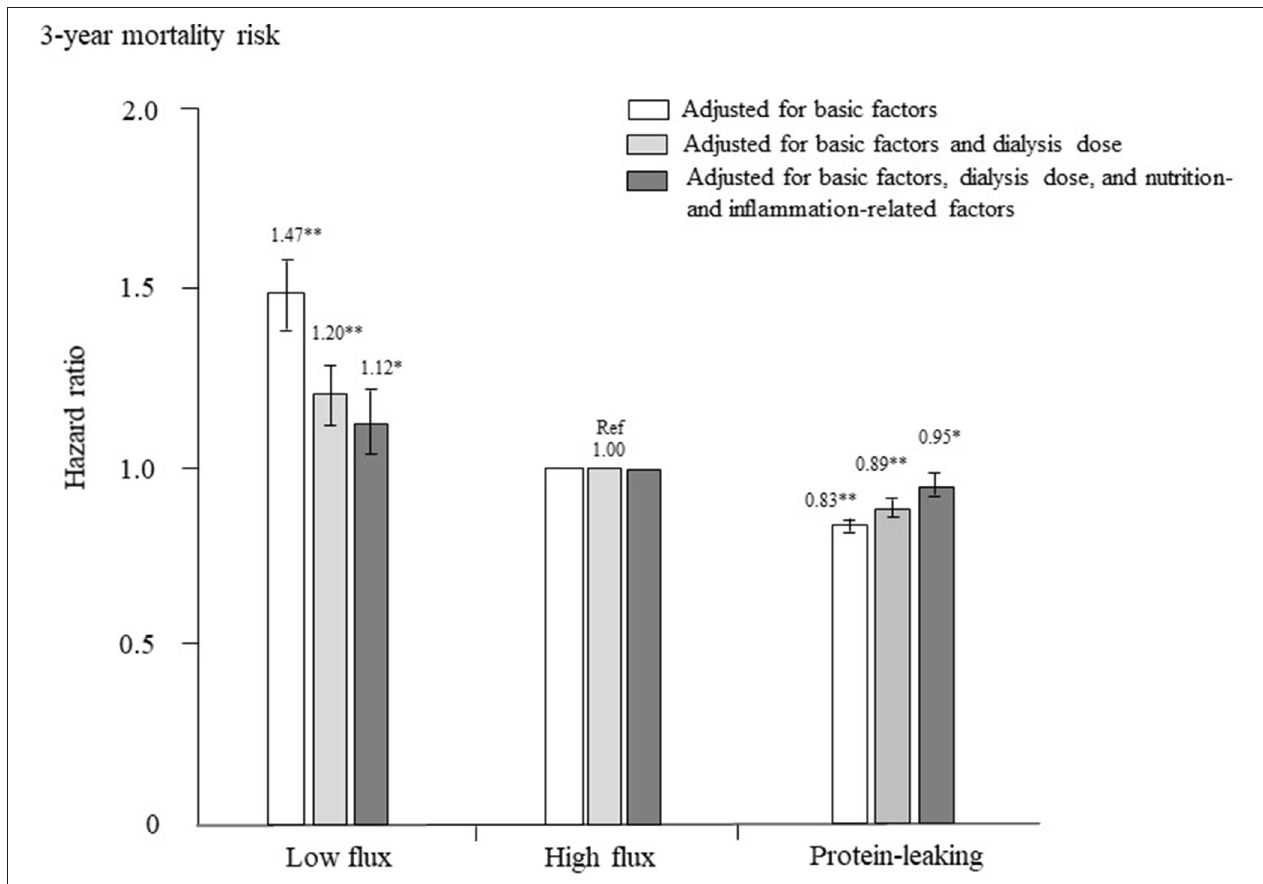
FIGURE 3 | Hazard ratios for all-cause mortality among the three dialyzer types in 238,321 patients undergoing hemodialysis, determined using standard Cox proportional hazards regression. White bars are adjusted for basic factors, including age, sex, dialysis vintage, presence/absence of diabetes mellitus, and presence/absence of cardiovascular complications. Gray bars are adjusted for dialysis dose, as assessed by Kt/V and β 2 -microglobulin levels, in addition to basic factors. Dark gray bars are adjusted for basic factors, dialysis dose, and nutrition- and inflammation-related factors, including body mass index, levels of C-reactive protein, hemoglobin, calcium, phosphate, intact parathyroid hormone, and serum albumin, normalized protein catabolic rate, and percent creatinine generation rate. * P < 0.01, ** P < 0.0001 vs. the high-flux dialyzer group (reference). Error bars correspond to 95% confidence